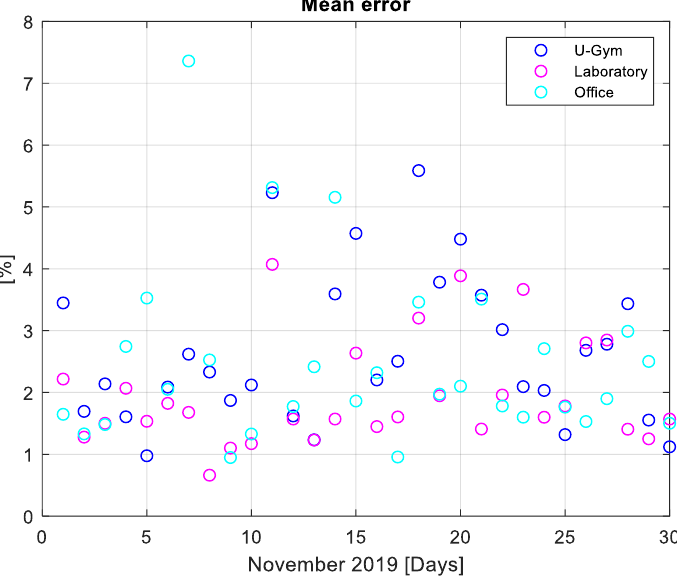
Figure 12. Daytime temperatures mean percentage error.